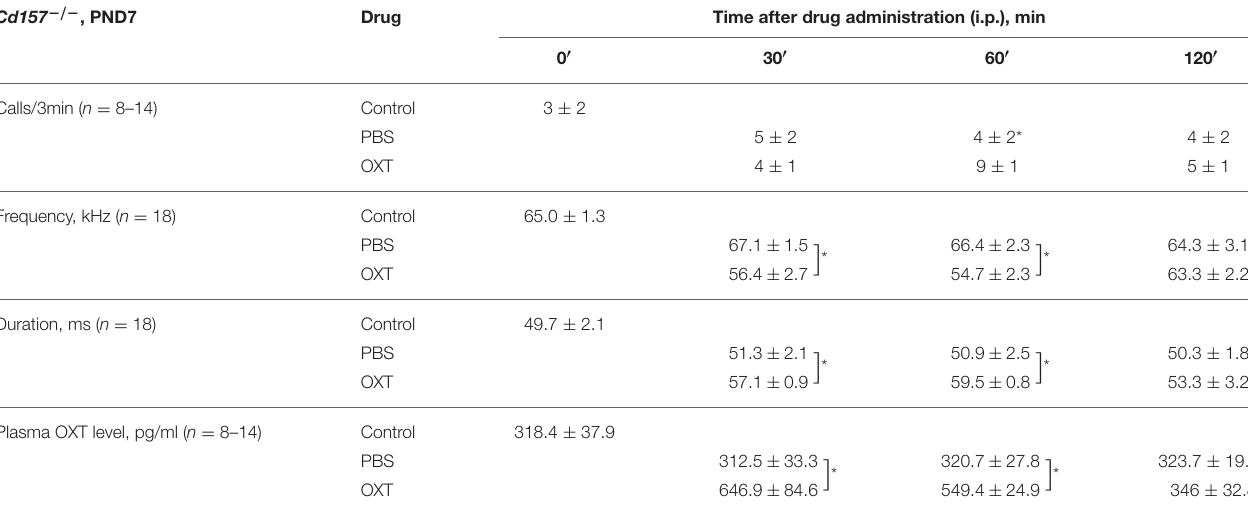
TABLE 1 | USV characterization and plasma OXT level after OXT administration in Cd157 − / − pups. Cd157 − / − , PND7 Drug Time after drug administration (i.p.), min 0 ′ 30 ′ 60 ′ 120 ′ Control 3 ±